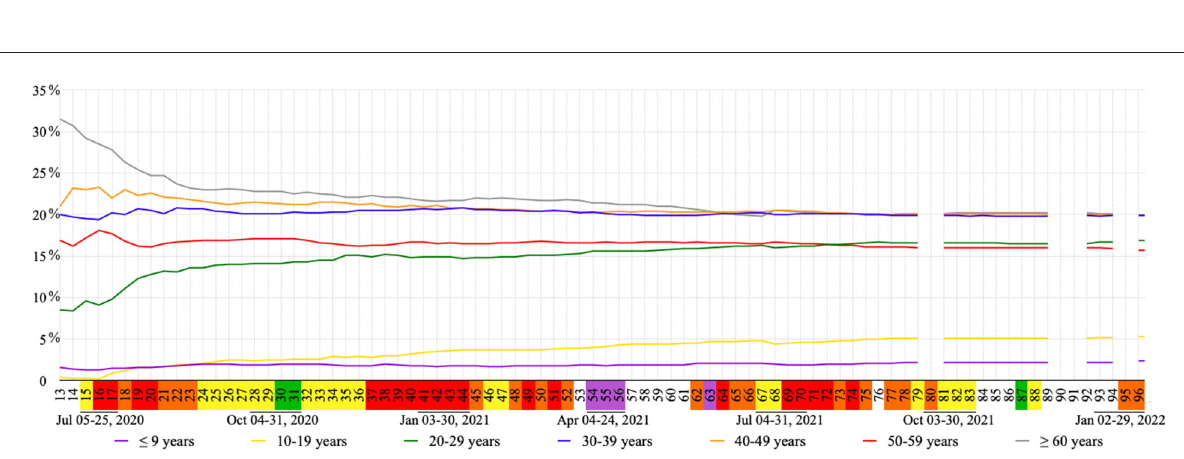
FrontiersinPublicHealth 06